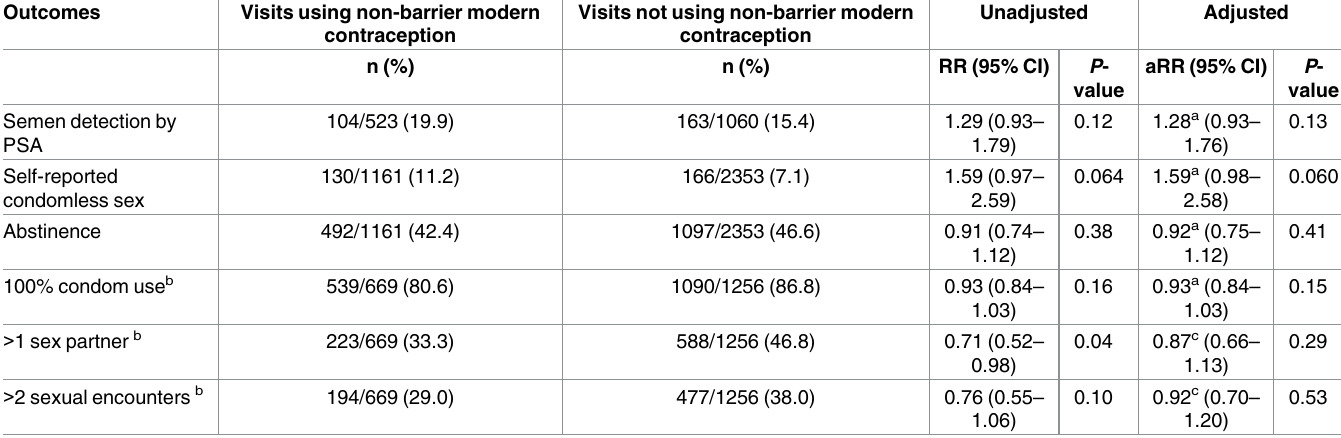
Table 2. Risk of prostate specific antigen detection in vaginal secretions and self-reported sexual behaviors in women using versus not using non-barrier modern methods of